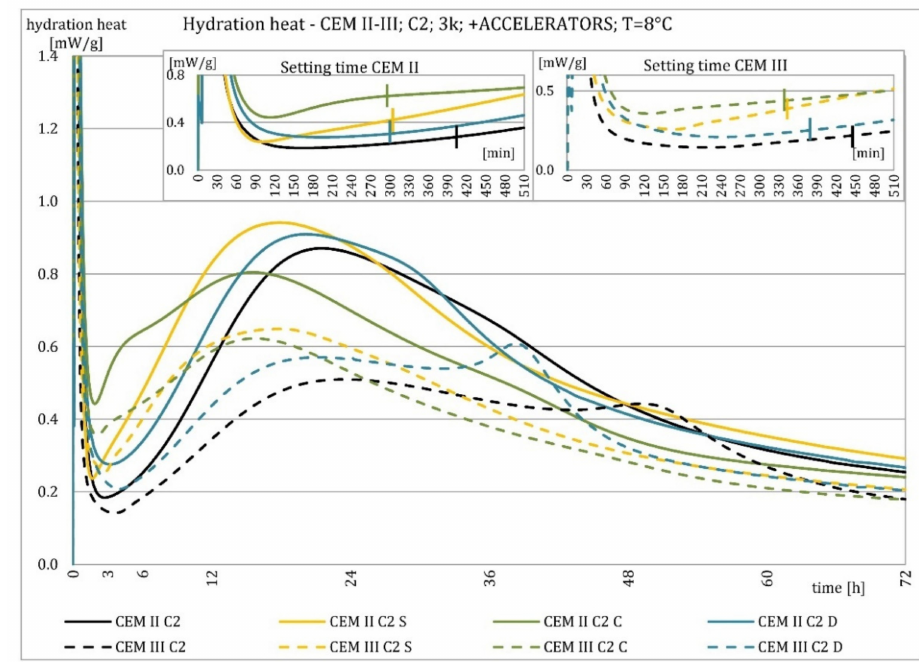
Figure 28. Hydration heat of C2 clinker-based cements CEM II/B-S, CEM III/A modified with accelerators at 8 ◦ C.